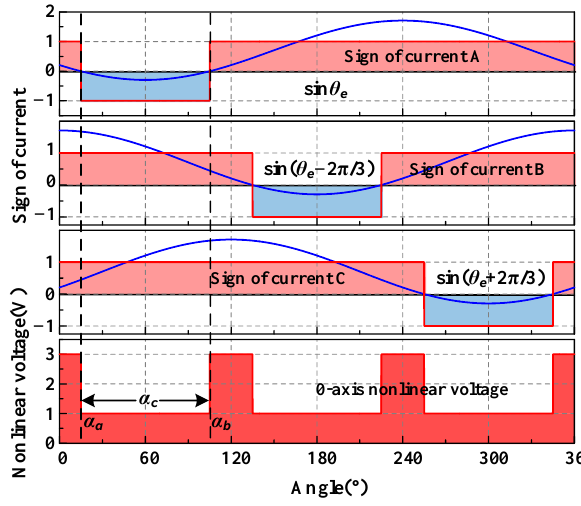
Figure 6. Diagram of 0 − axis nonlinear voltage.